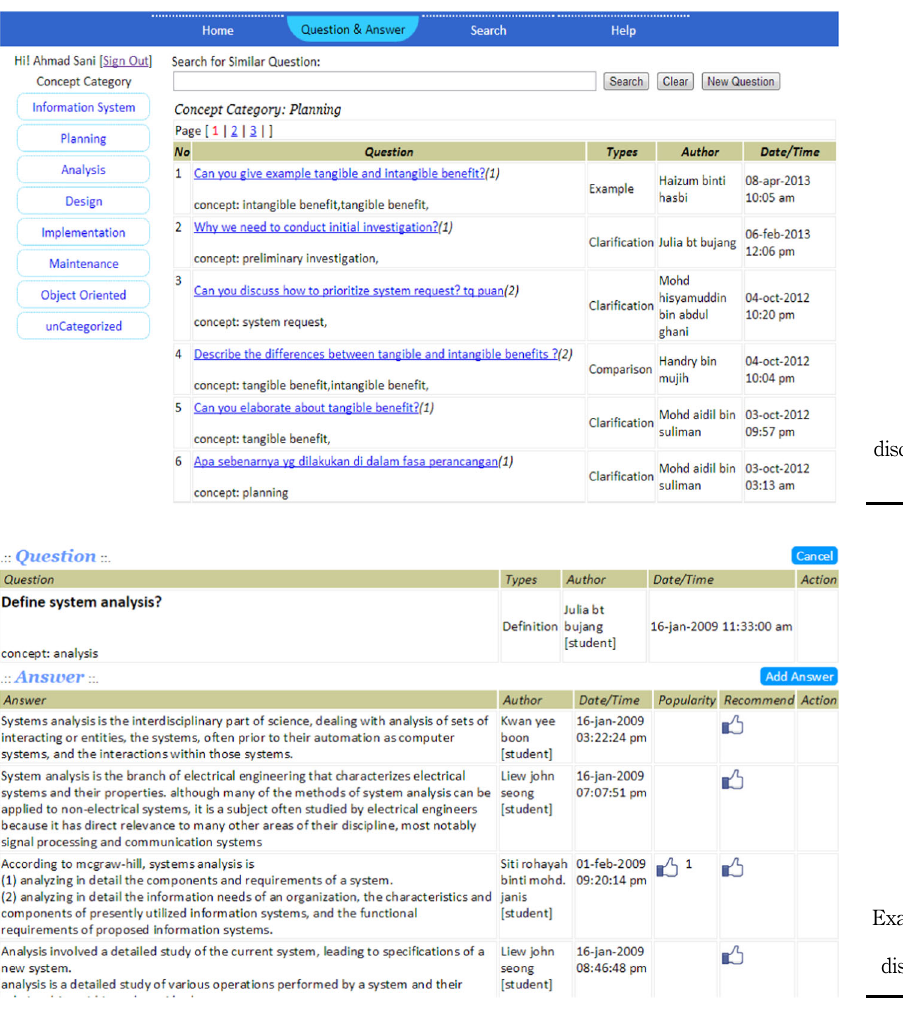
Figure 9. Example of question and answer discussion